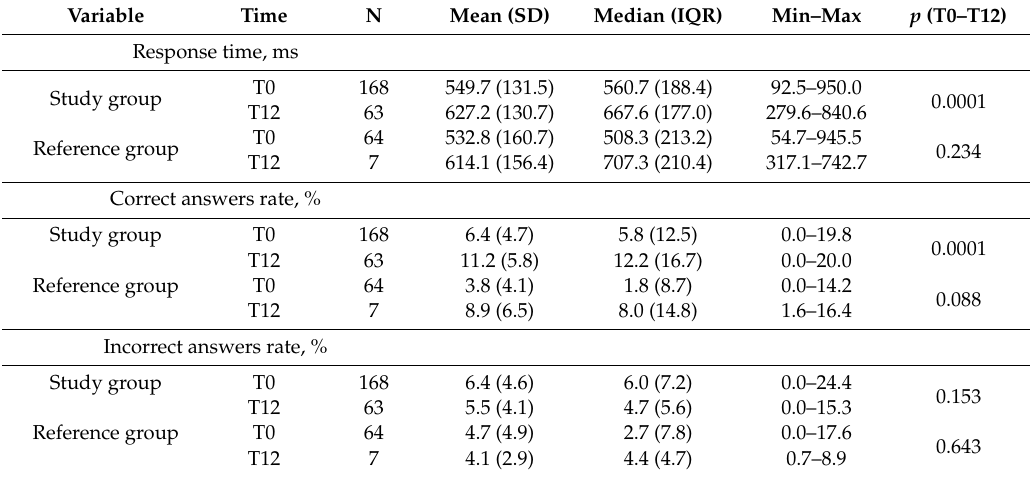
Table 3. Changes in cognitive parameters within the study and reference group throughout the